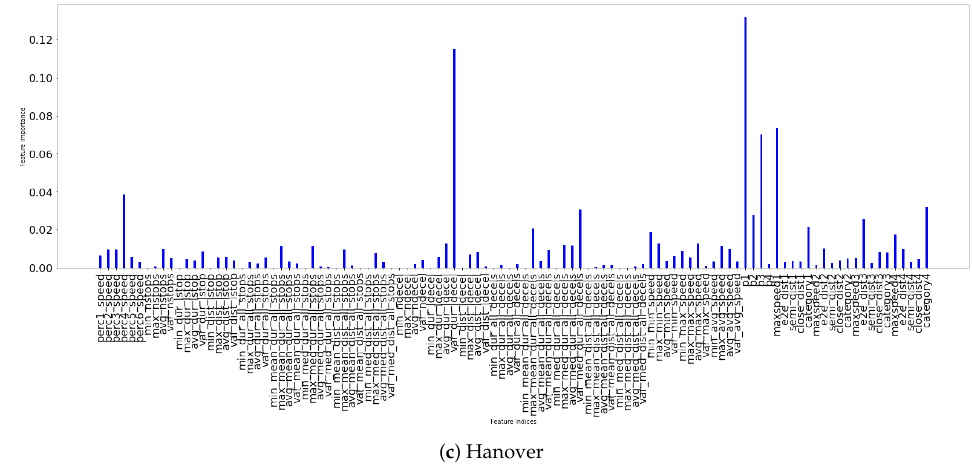
Figure 10. Feature importance for the the three datasets. Table 5. Classification results of the tuned hybrid all-static